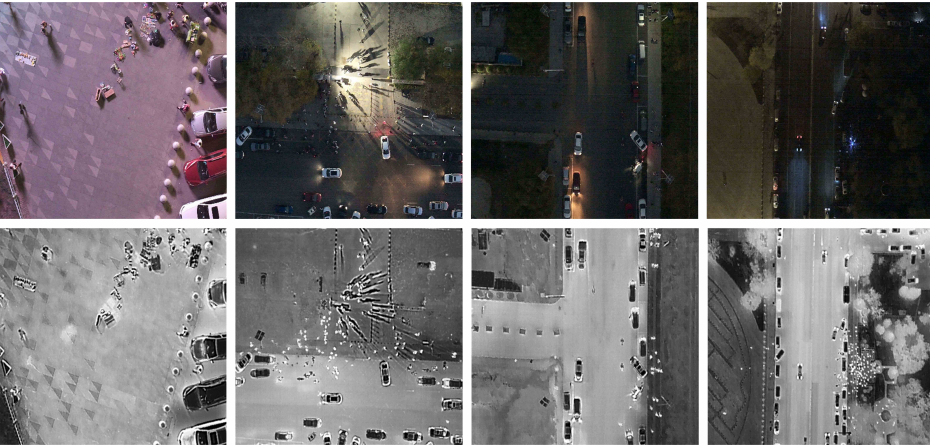
Figure 1. Some examples of paired infrared and visible images. The first row is the visible image and the second row is the infrared image.